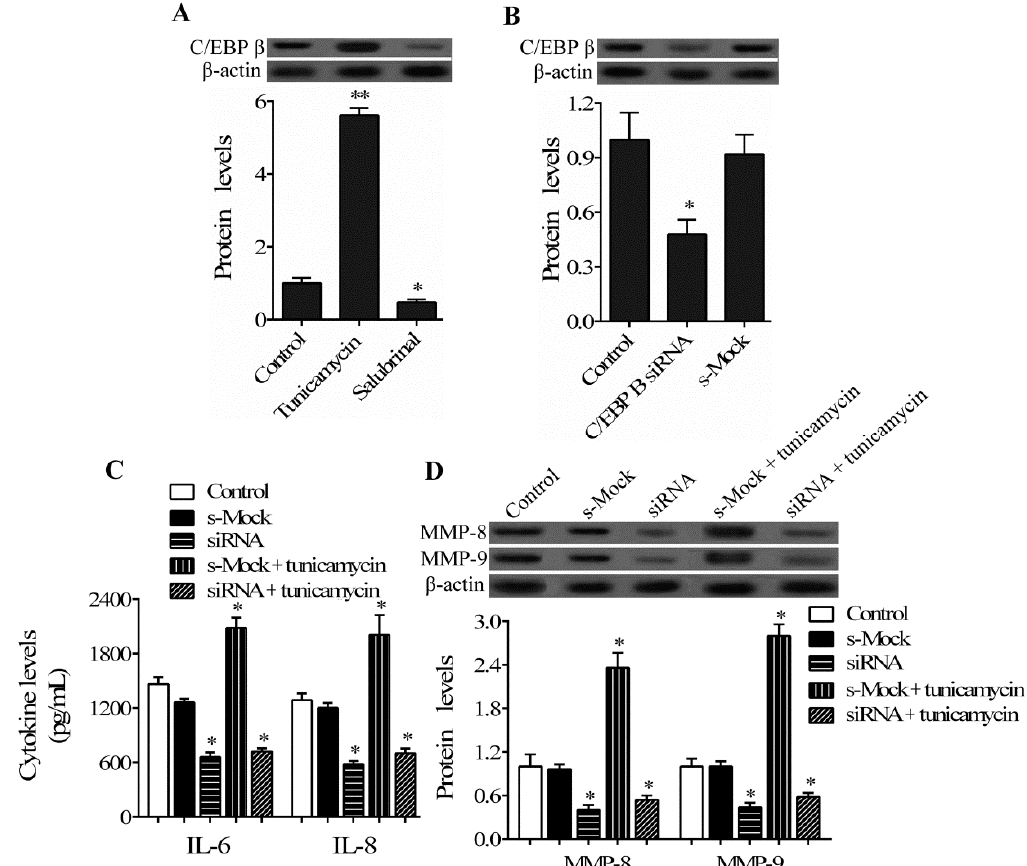
Figure 4. Interplay between C/EBP β and endoplasmic reticulum (ER) stress in hPDLCs. ( A ) hPDLCs were pretreated with 5 μ g/mL tunicamycin or 10 μ M salubrinal for 2 h, followed by stimulation with P. gingivalis LPS for 24 h. The expression of C/EBP β in hPDLCs was then analyzed by Western blotting; ( B ) hPDLCs were transfected with C/EBP β siRNA or non-targeting control siRNA (s-Mock) for 48 h, followed by stimulation with P. gingivalis LPS for another 24 h. The protein level of C/EBP β was determined by Western blotting to confirm the efficiency of siRNA; ( C , D ) C/EBP β siRNA-transfected hPDLCs were pretreated with tunicamycin, followed by stimulation with P. gingivalis LPS. The levels of IL-6 and IL-8 and the expression of MMP-8 and MMP-9 in hPDLCs were then analyzed by ELISA and Western blotting, respectively. Untransfected hPDLCs treated with LPS were used as the control. (* p < 0.05, ** p < 0.05 vs. control).